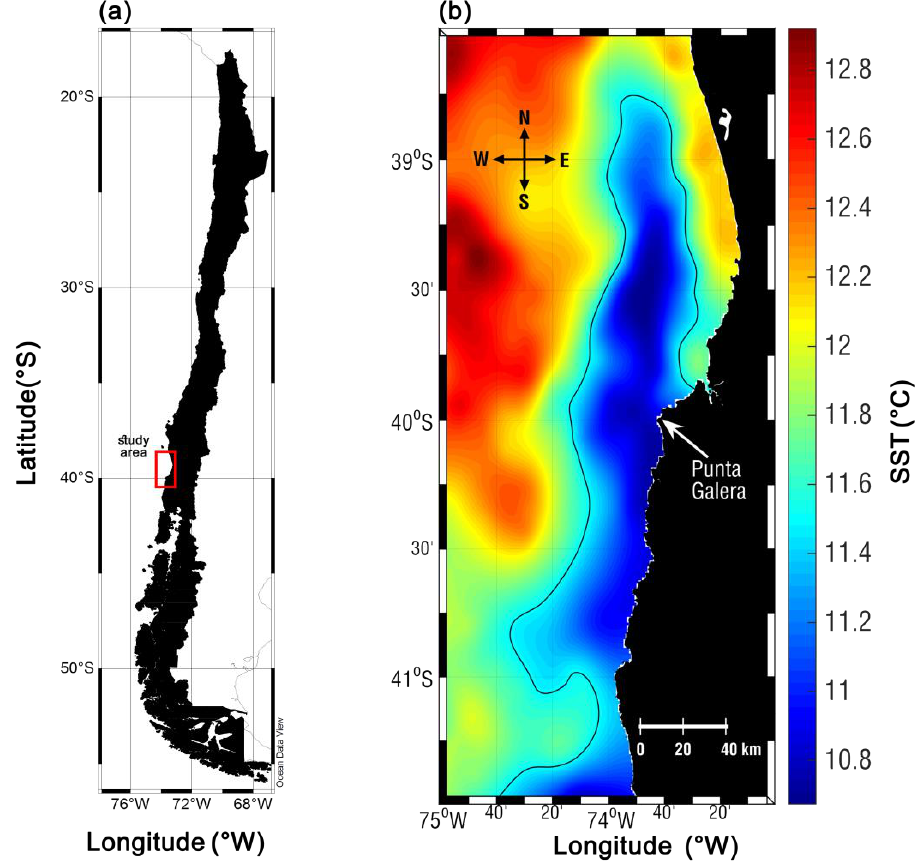
Figure 1. Southeastern Pacific along continental Chile ( a ) and the study area (red box) off central-southern Chile ( b ), which includes sea surface temperature (SST, color, °C) from 21 st October, 2013, which represents coastal upwelling in austral spring.